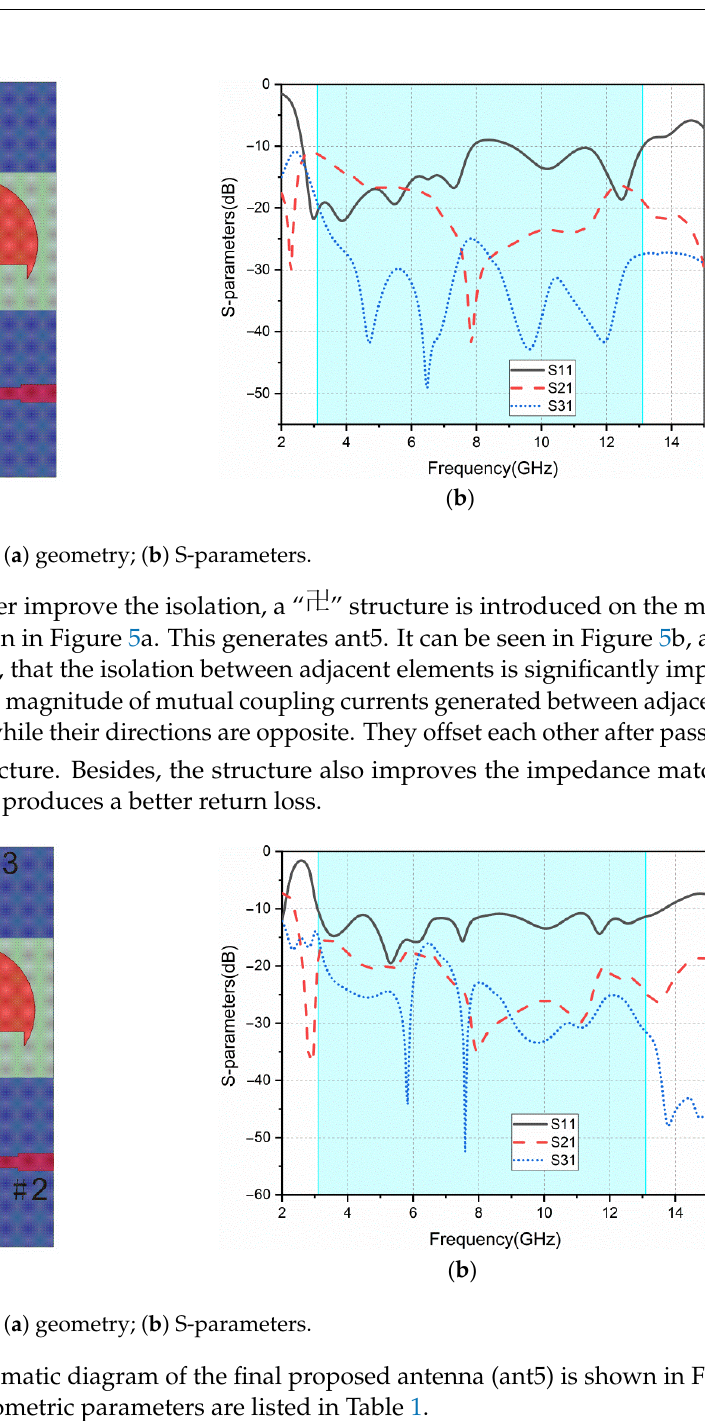
Table 1. Geometric parameters of the proposed MIMO